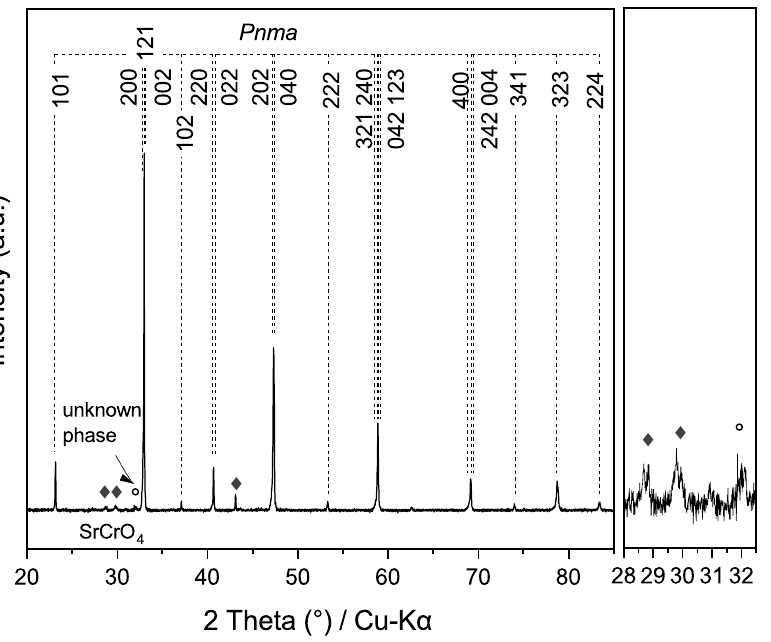
Figure A3. XRD pattern of Pr 0.3 Sr 0.7 (Cr,Mn,Fe,Co,Ni)O 3– δ powder treated after 1673K for 10h. Reflections were indexed according to the results of Rietveld refinement using PrCrO 3 (ICSD 251098) as the starting